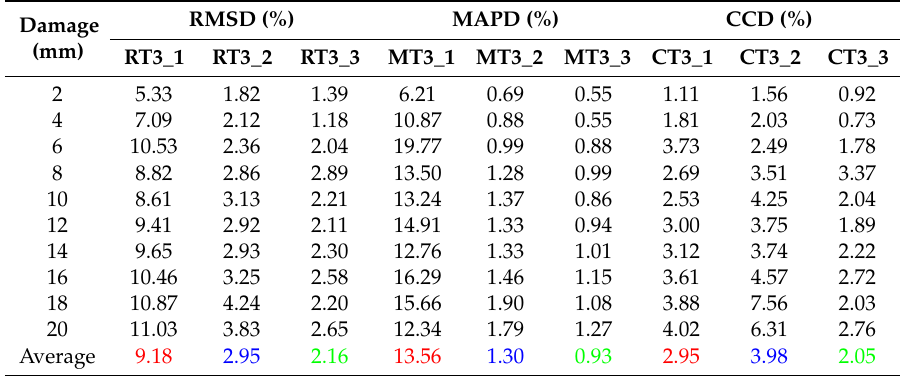
Numbers in different colors represent colors in picture. Table 3. Three statistical metric values for the T4_1, T4_2 and T4_3 experiment. Damage